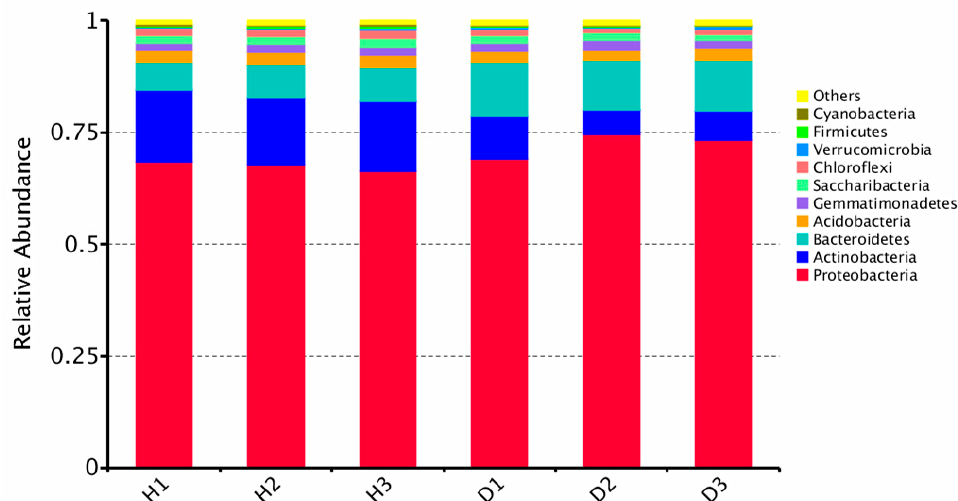
Figure 1. Analysis of culture-independent endophytic communities at phylum level in the cucumber roots. H1–3, healthy samples; D1–3, diseased samples.